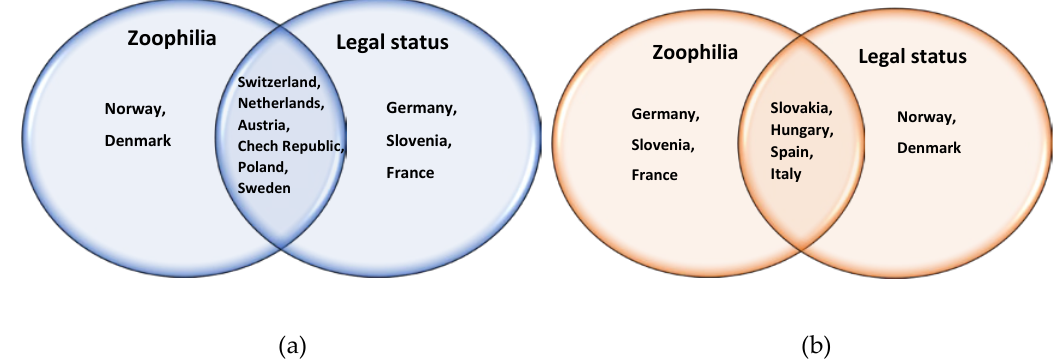
Figure 3. Rankings of the examined countries according to the legal status of the animals and the regulation of zoophilia. ( a ) High-ranking (1–3) countries; and ( b ) low-ranking (4–5) countries).